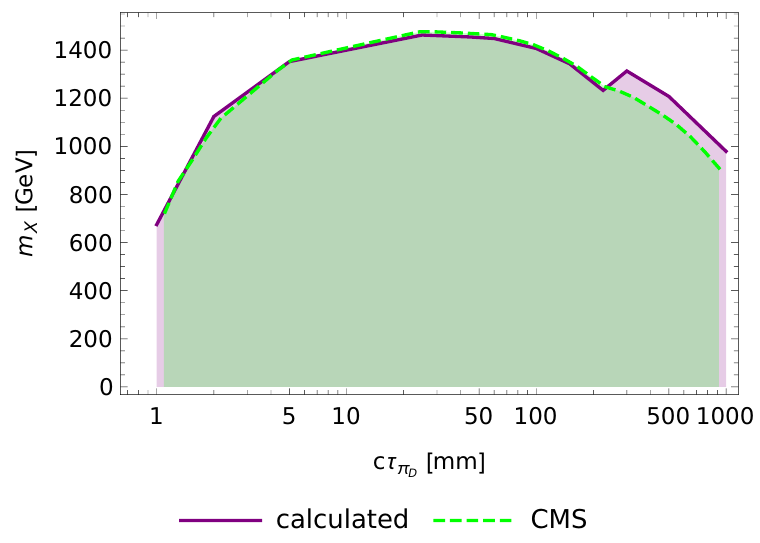
Figure 5. Constraints on the mediator mass from the emerging jets search. In dashed green: limit from CMS [23]. In solid purple: our recast, for m π